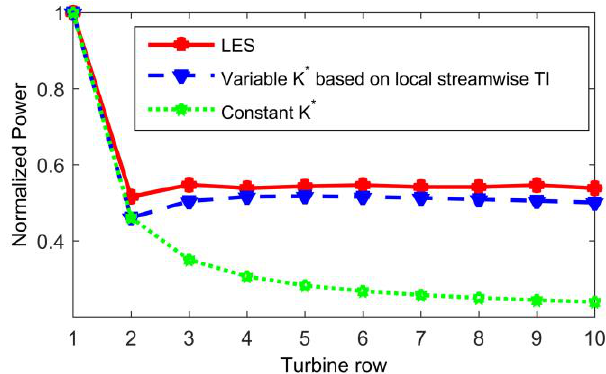
Figure 7. Comparison of the power output for 𝜃 𝑤𝑖𝑛𝑑 = 270° obtained with the new analytical model using a constant wake growth rate and a variable wake growth rate based on the local streamwise turbulence intensity.